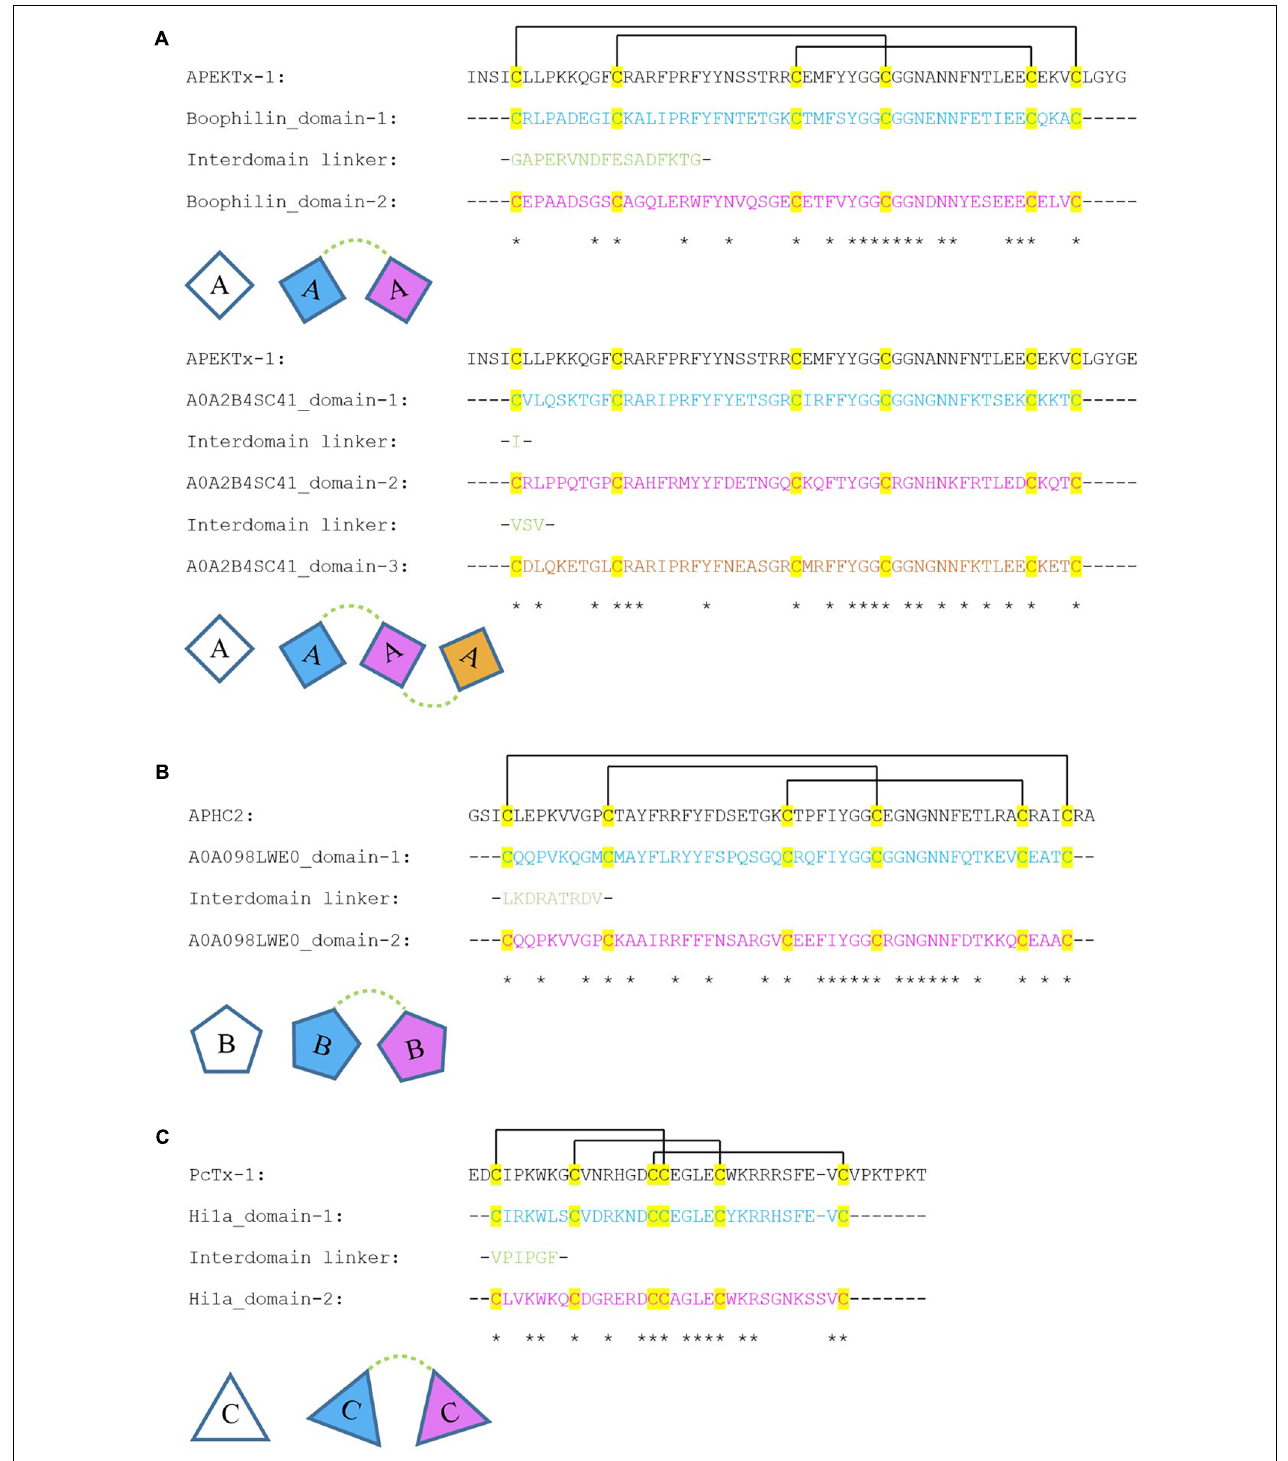
FIGURE 9 | Alignment of single domain toxins with multi-domain SCREPs. These series of alignments are between three single domain ion channel impairing toxins; (A–C) with the domains of four SCREPs. The disulfide connectivities are indicated by lines between cysteine residues. The top alignment is between APEKTx1 (A) , Boophilin [AA], and the novel three-domain SCREP sequence; A0A2B4SC41 [AAA]. The middle alignment is between APHC2 (B) and the two domain SCREP sequence; A0A098LWE0 [BB]. The bottom alignment is between PcTx-1 (C) and the double ICK SCREP Hi1a [CC]. All uncharacterized proteins have been labeled with their associated UniProt